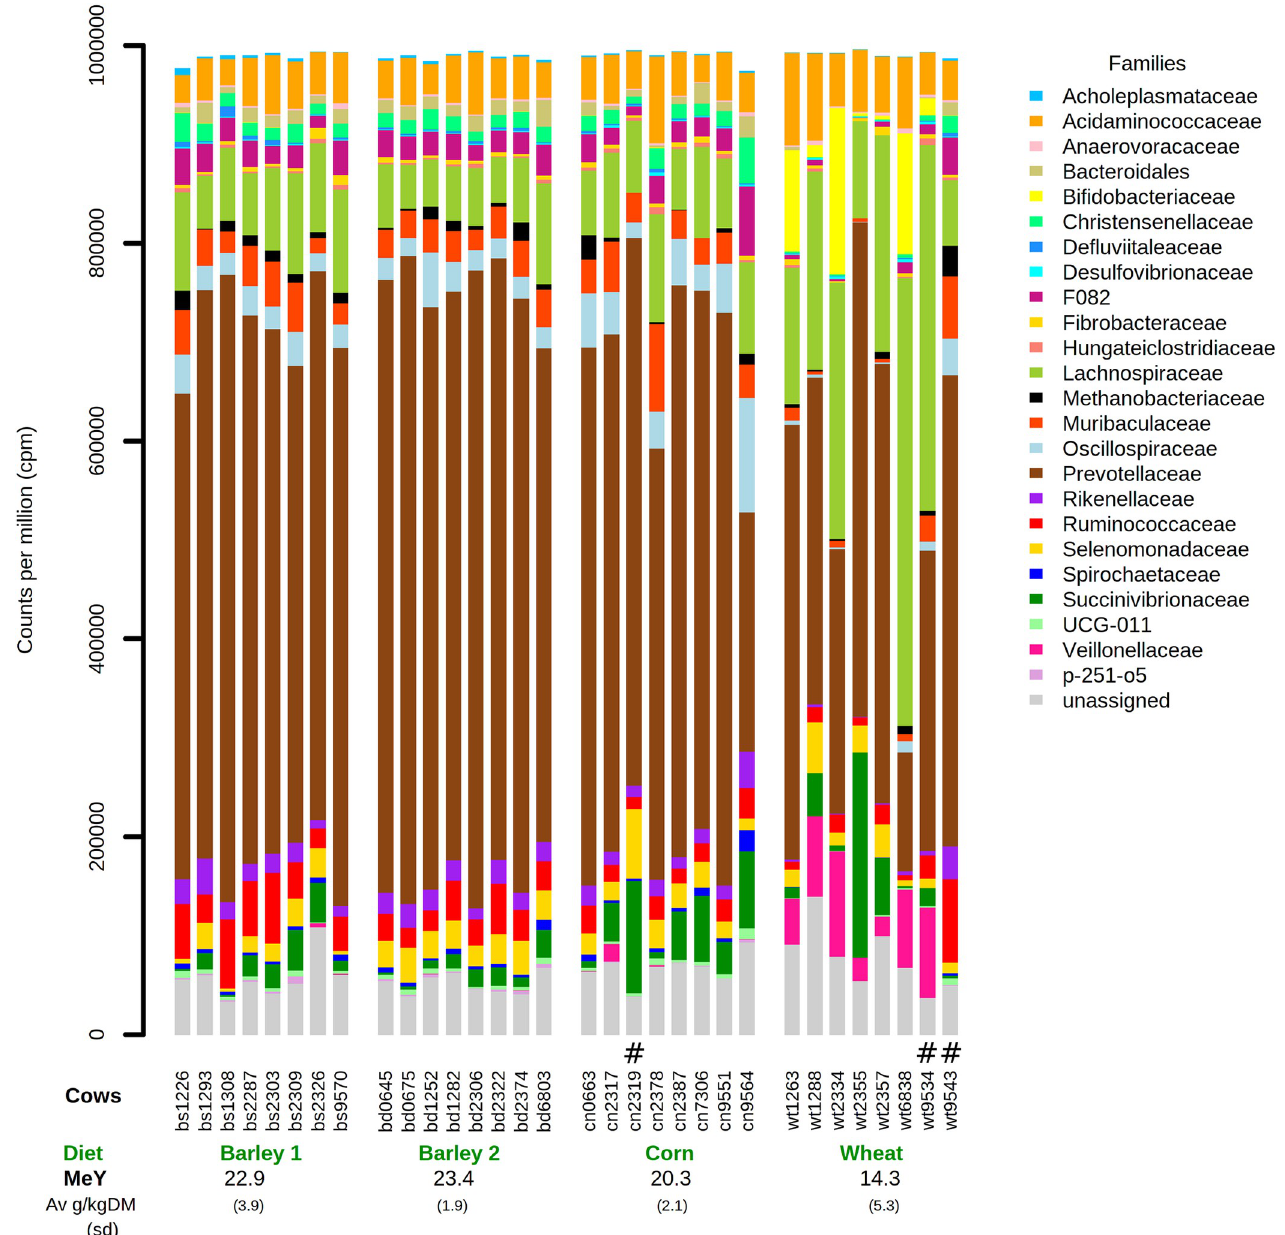
Fig 2. Stacked barplot of the abundance in counts per million (cpm) of the 25 most abundant bacterial plus archaeal families from 32 rumen samples. Also shown is the mean +/- sd CH4 yield (MeY) as gm CH4 per kg DMI for each group of cows and the diet of the group. # indicates cows treated with antibiotics before the feeding trial (Mastalone/wt9543, Yodimaspen/wt9534,